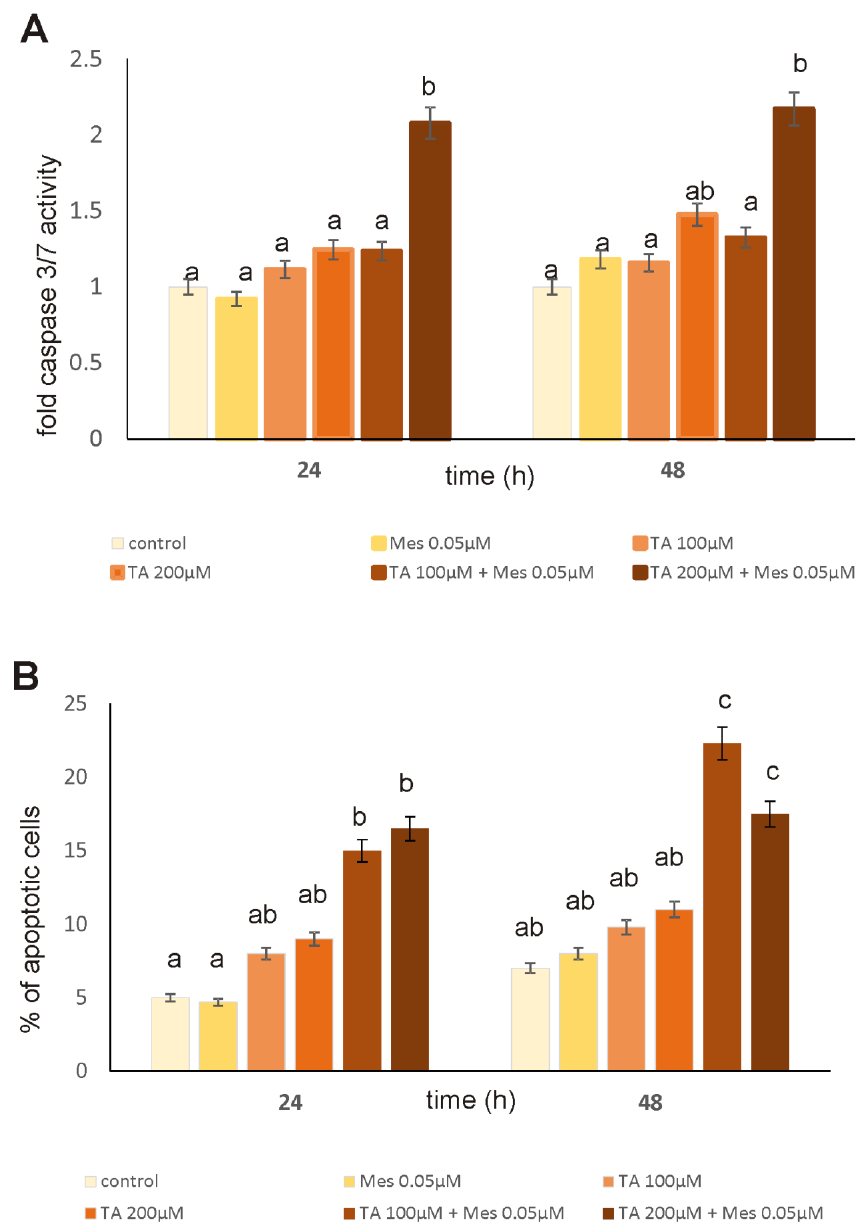
Figure2. Thee ff ectofTA,Mes, andthecombinationofTA + MesonapoptosisinZR-75-1cells, whichwere incubated with 100 µ M of TA, 200 µ M of TA, 0.05 µ M of Mes, and a mix of 100 µ TA + 0.05 µ M Mes, 200 µ M TA + 0.05 µ M Mes. ( A ) Caspase 3 / 7 activity in ZR-75-1 cells under the influence of TA, Mes and TA + Mes on, ( B ) Bar graphs presenting the percentage of apoptotic cells. Mean values from three independent experiments ± SD are shown. Di ff erent letters indicate statistical di ff erences ( p ≤ 0.05) between treatments estimated by Tukey’s